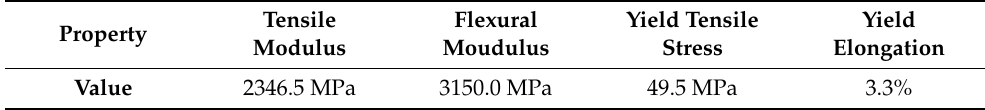
Table 3. The mechanical properties of Polylactide (PLA).